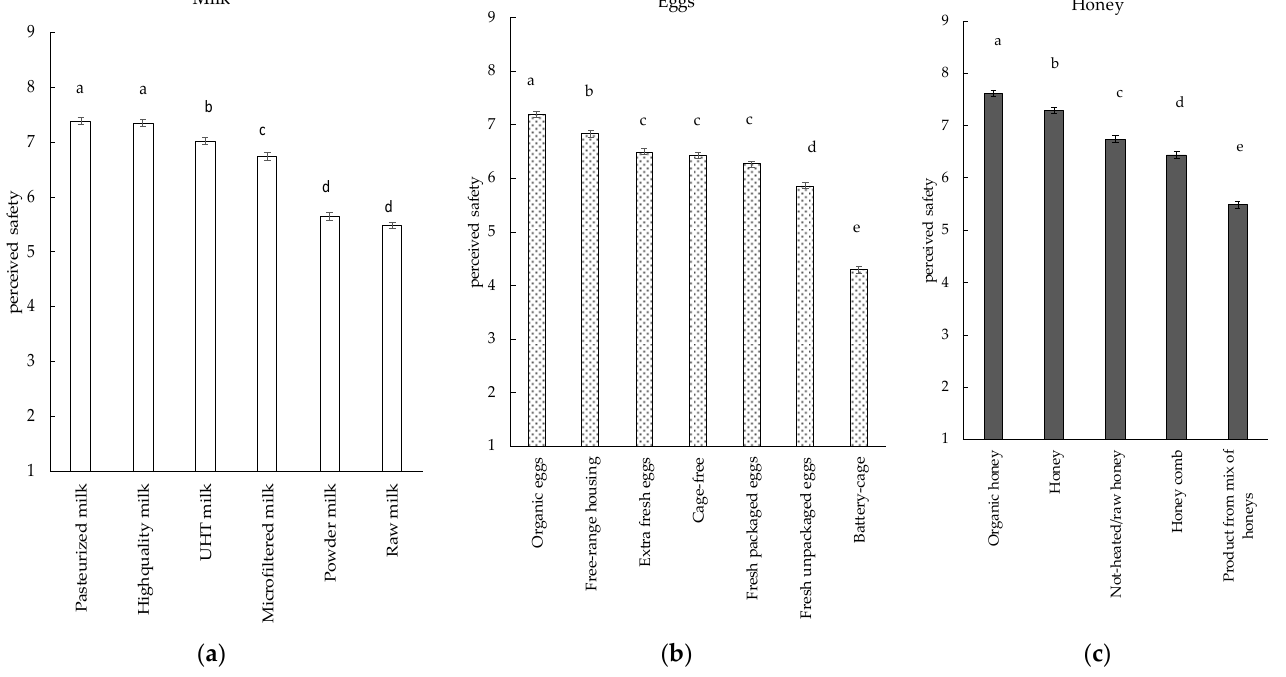
Figure 1. Perceived safety of different commercial types of milk ( a ), eggs ( b ), and honey ( c ) from 489 respondents. In each figure, different letters indicate statistical different mean values from two-way ANOVA models (fixed factor: level of technological transformation or commercial type; random factor: subject).